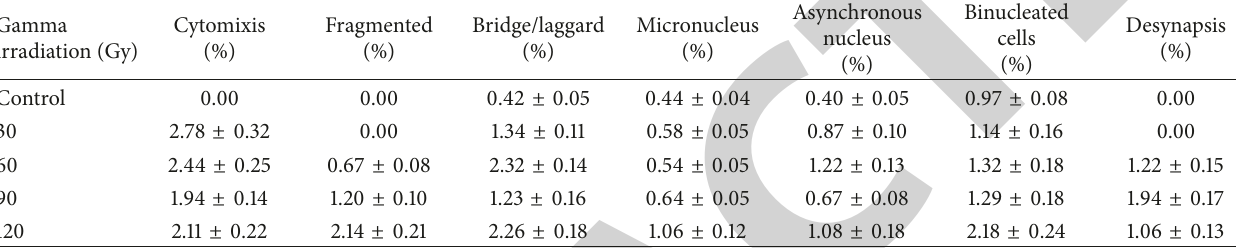
Table 6: Effect of gamma irradiation on mitotic aberrations of Onobrychis viciifolia in in vitro growth